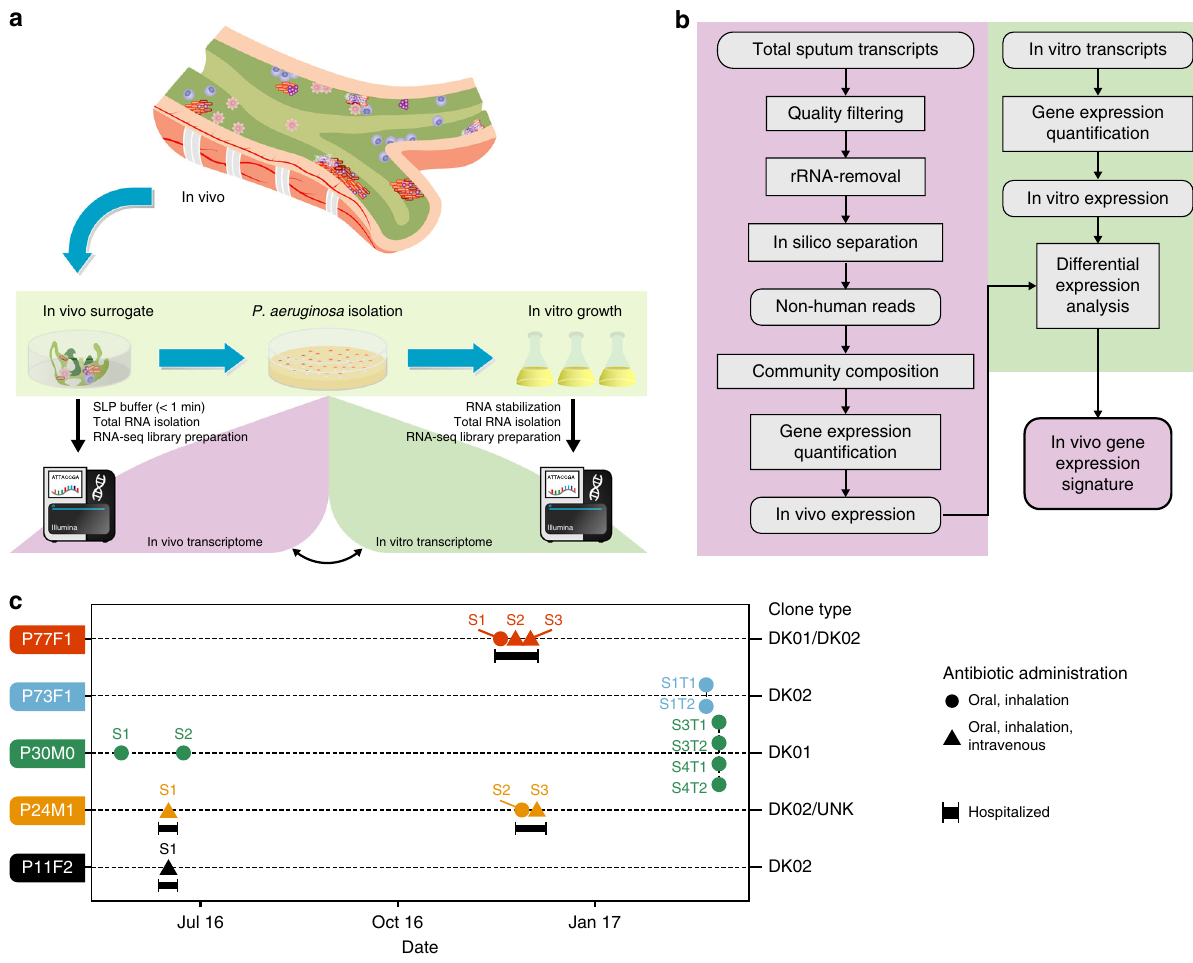
Fig. 1 Experimental design and patients included in the study. a Schematic representation of the experimental design. In the thick mucus layer, bacterial communities thrive in a harsh environment. To capture the best representation of in vivo transcription, sputum samples were collected directly from adult CF patients followed at the Copenhagen Cystic Fibrosis Clinic at Rigshospitalet and nucleic acid content was stabilized in less than 1 min using sputum pre- lysis and preservation buffer (SLP buffer), followed by total RNA isolation, RNA-seq library preparation, and sequencing (for a complete description see Methods). From the same or a second sputum sample, we isolated, for some patients, more than ten single P. aeruginosa clones and studied their gene expression in laboratory condition (in vitro). b Simpli fi ed schematic representation of the in silico analysis work fl ow. Total reads were quality- fi ltered and any rRNA contaminant removed. Human reads were separated by mapping high-quality reads directly on human GRCh38 genome. Reads not assignable to human genome were used to evaluate microbial community composition and to assess in vivo P. aeruginosa gene expression. Transcription deriving from in vitro cultures of P. aeruginosa were used as a reference for identifying differentially gene expressed in vivo. c Overview of longitudinally collected samples. Clone types colonizing each patient are reported. Assignment of clone type was obtained by whole genome sequences from isolates